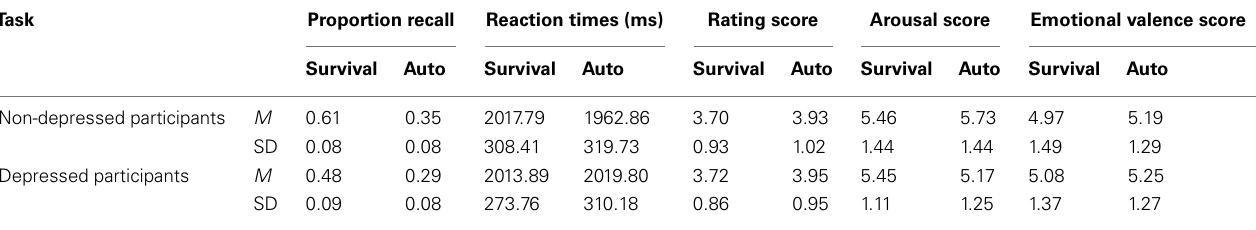
Table 2 | Mean proportion of recall, reaction times and ratings score in non-depressed and depressed participants.